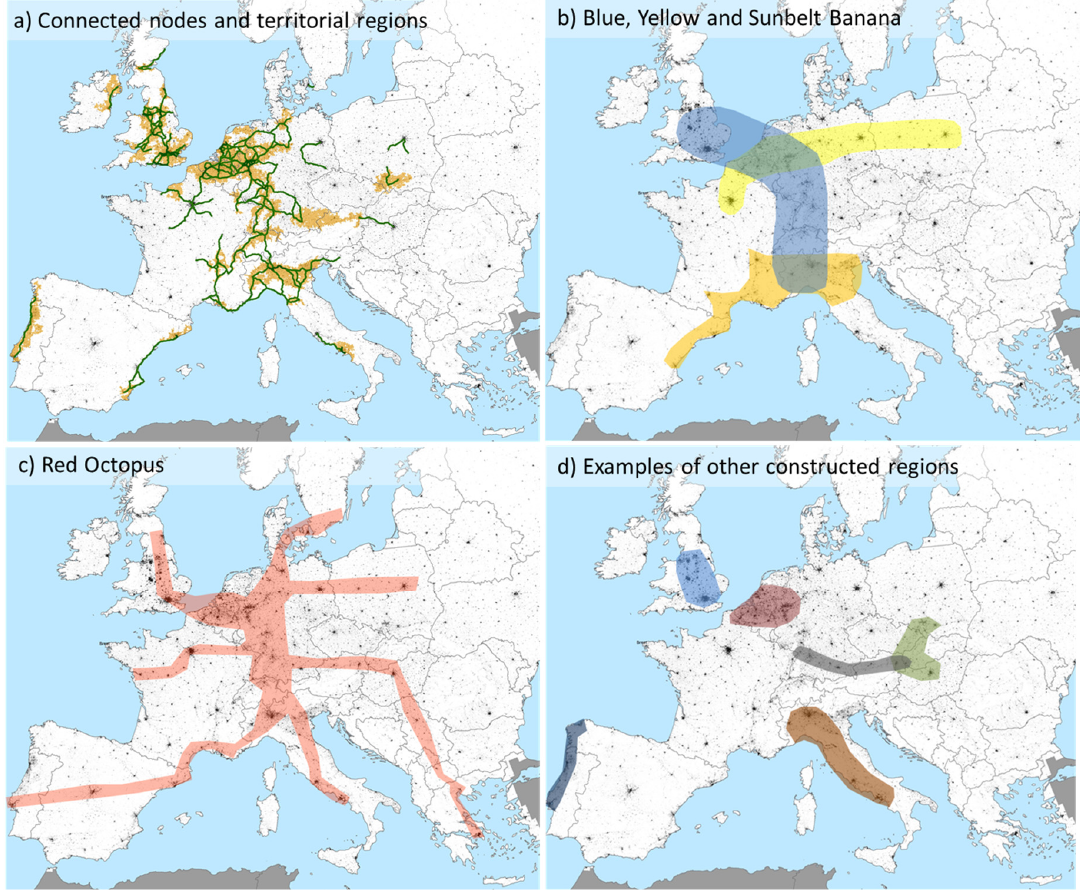
Figure 7. Constructed European regions: ( a ) Conjugation lines between nodes classified as connected (based on settlement contiguity) spanning soft spaces as well as related territorial regions based on region-growing around nodes using settlement density—as used in this study and shown in Figures 2 and 3; ( b ) The ‘Blue Banana’ [17], the ‘Yellow Banana’ (e.g., [22]) and the ‘Sunbelt Banana’ [18] spatially conceptualized by economic developments; ( c ) the ‘Red Octopus’ [19] spatially conceptualized by economic developments; ( d ) Examples of constructed regions: brown (Milan-Rome-Naples), light blue (London-Leeds) [16] using economic developments, dark blue (Lisbon-Vigo), green (Vienna-Bratislava-Budapest-Krakow) [69], grey (Karlsruhe-Vienna) [8] using night-time lights; red (Ruhr-Randstaad) identified as mega-region by any data set (e.g. [14,69].